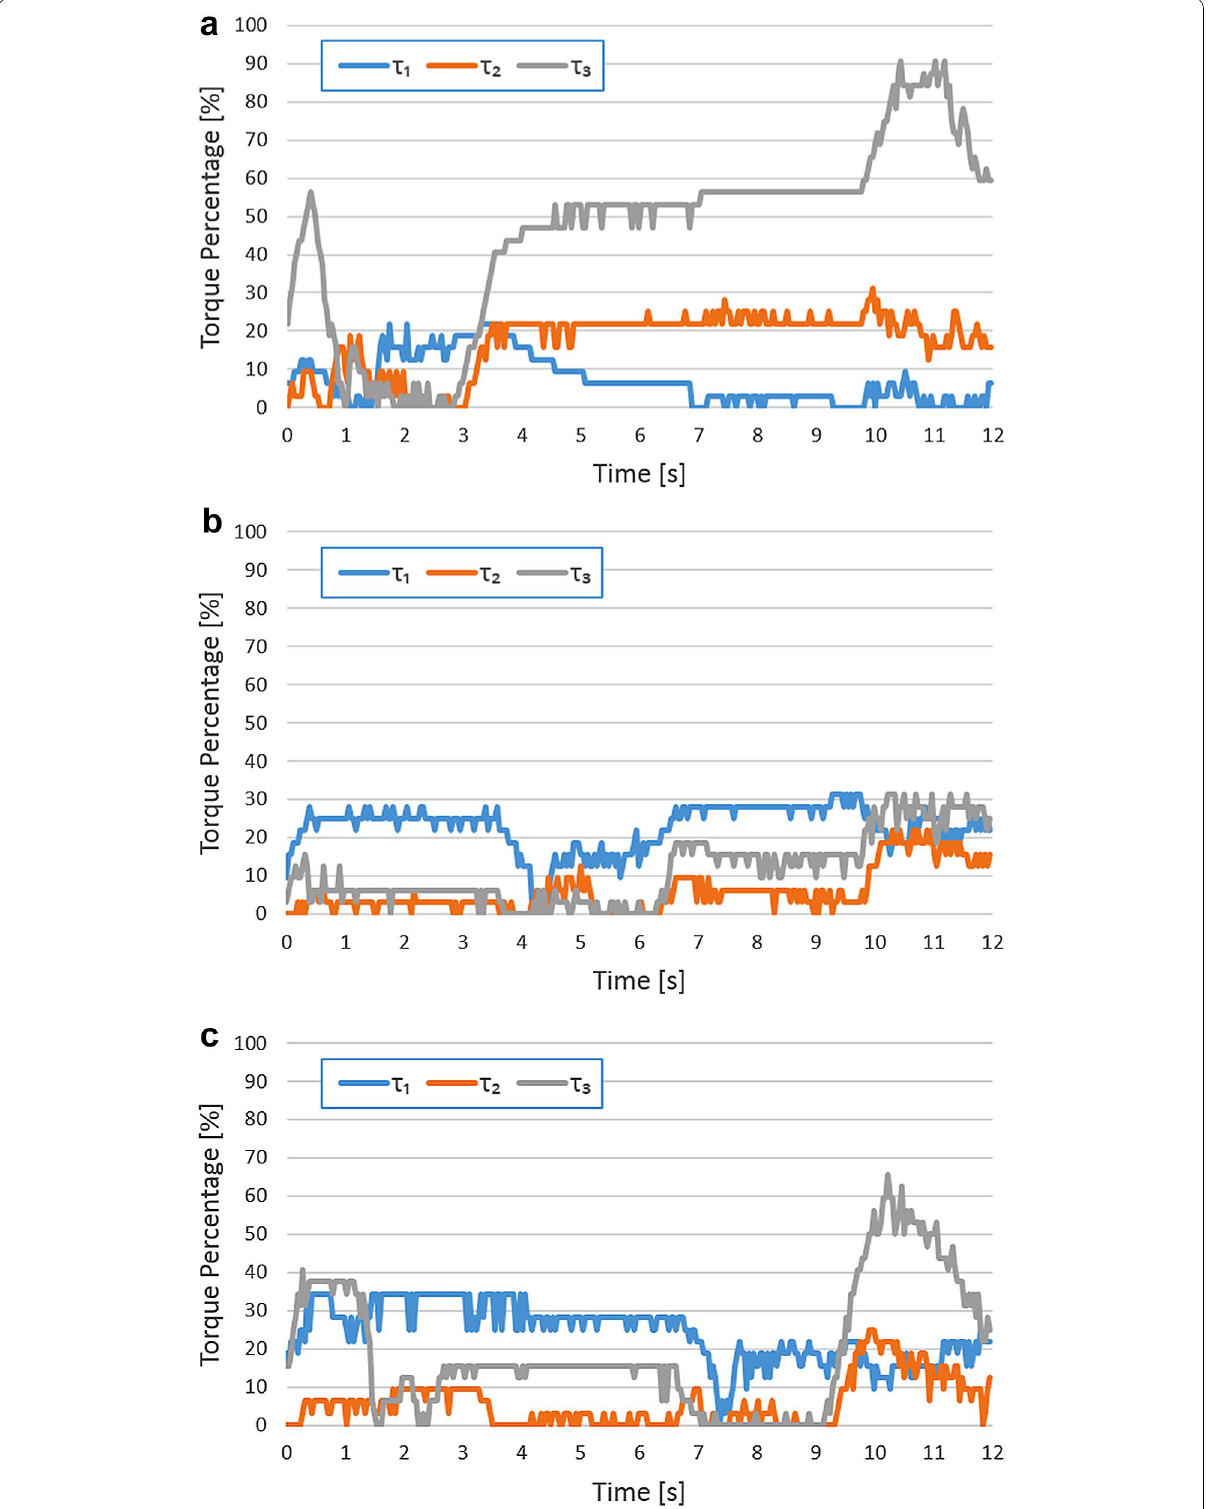
Fig. 12 Servo torque evolution during vertical-body climbing gait using power efficiency model a Limb from pair 1, b Limb from pair 2, c Limb from pair